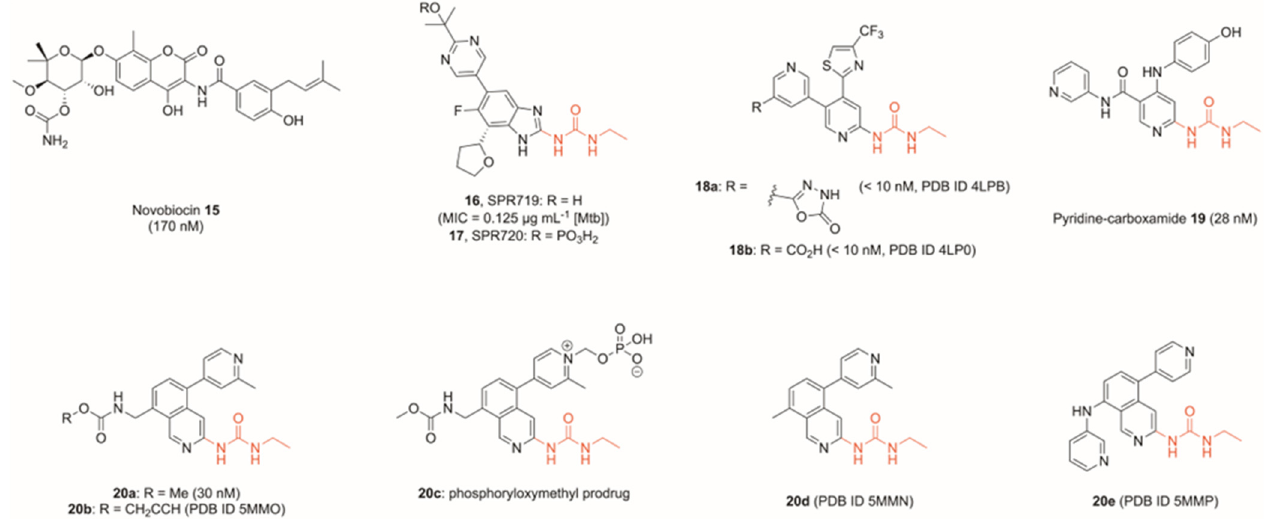
Figure 6. Examples of topoisomerase ATPase domain inhibitors with IC 50 values against E. coli DNA gyrase unless stated otherwise. An ethyl urea moiety (red) was identified as an important motif capable of forming two key interactions with a conserved aspartate residue, and was subsequently used by multiple researchers in the development of novel topoisomerase inhibitors.